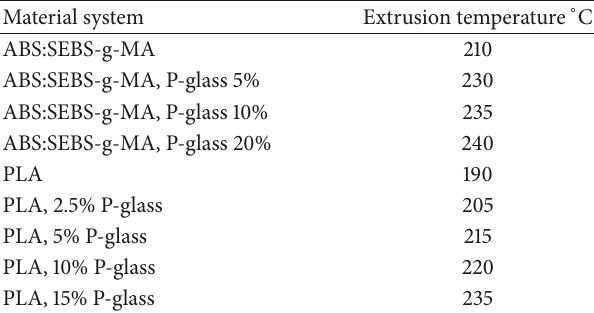
Table 1: Extrusion